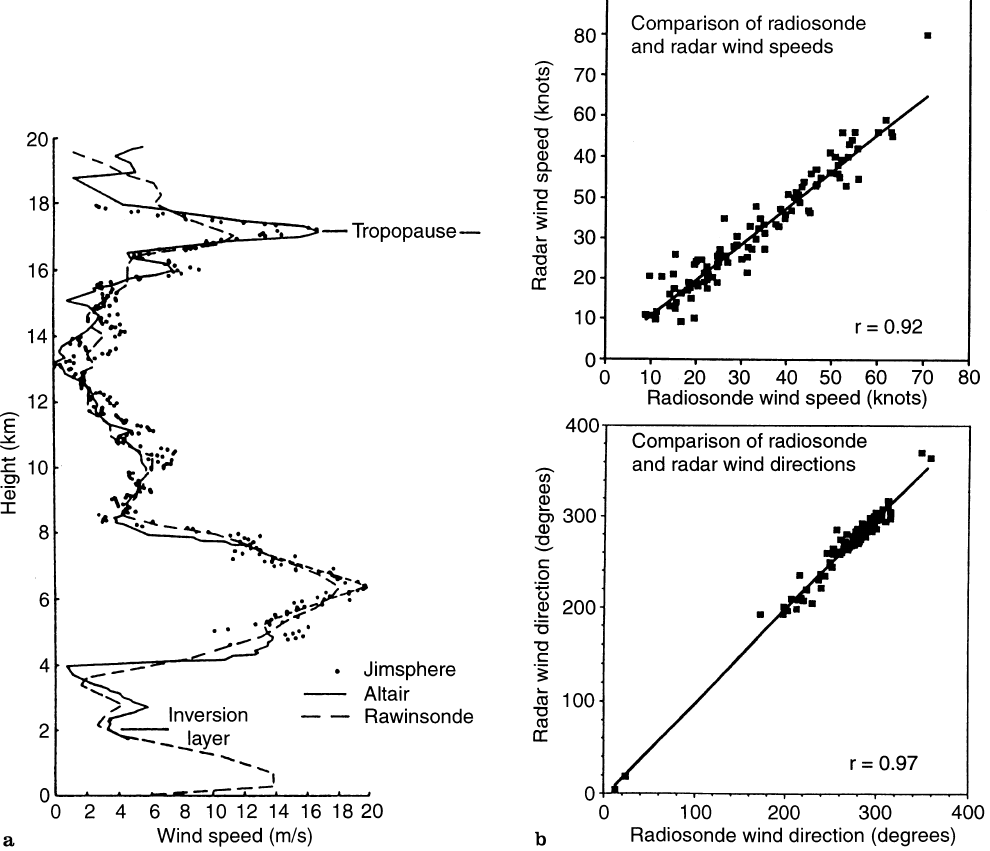
best fit for the magnitudes is not quite 1.0, due to the e(cid:128)ect scatterer anisotropy. This e(cid:128)ect is usually corrected for, but we have chosen not to do so in this case. See the text for a more extensive discussion of